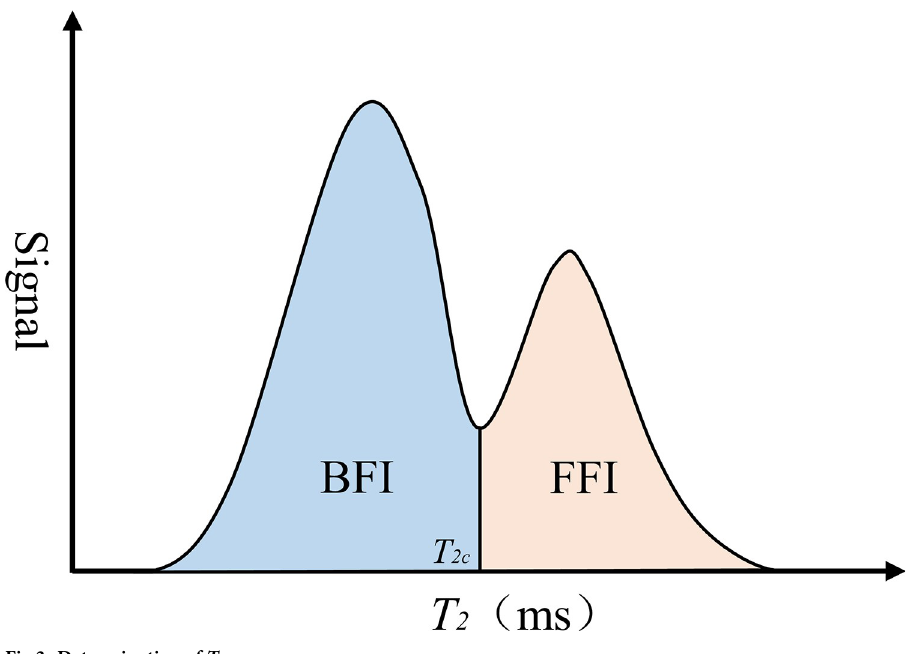
Fig 3. Determination of T 2c .